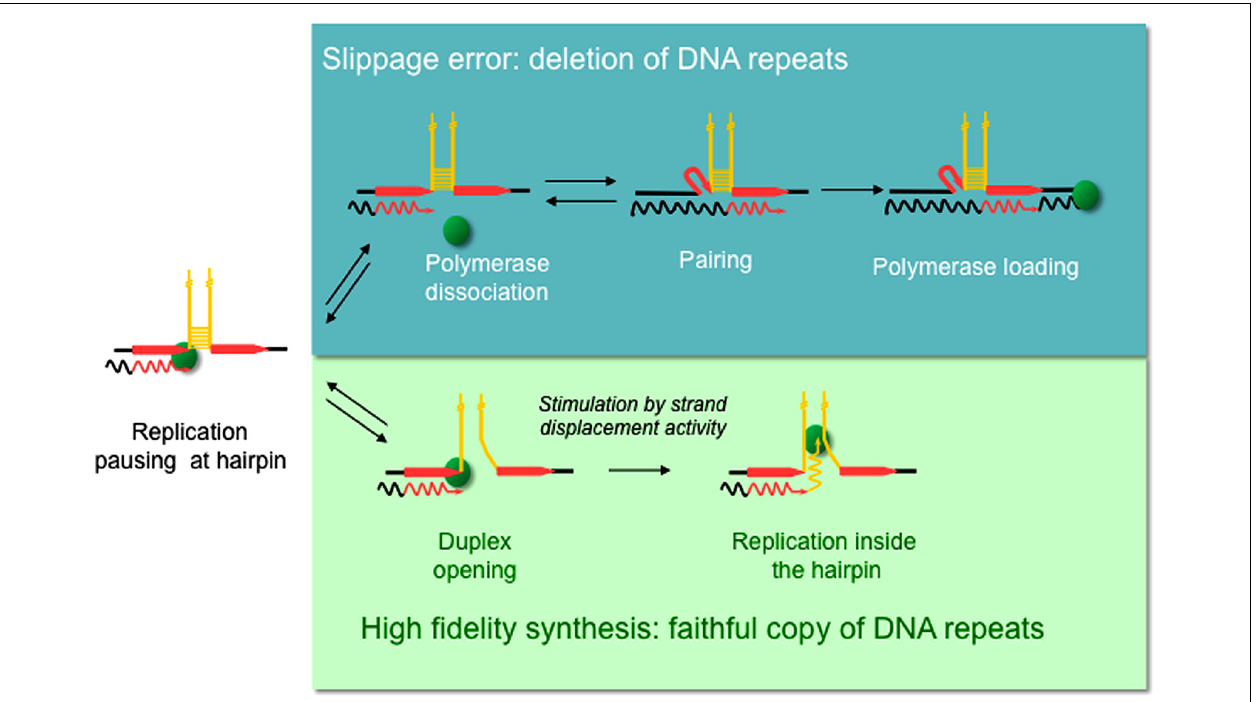
direct repeat at the base of the hairpin, (2) polymerase dissociation, and (3) strand misalignment, where the 3’ end of the nascent strand unpairs from the complementary strand and reanneals with the second direct repeat, thus generating a deletion (Viguera etal., 2001a). However, a polymerase with high strand displacement activity is able to open the hairpin duplex (bottom) and replicate the repeat-containing template